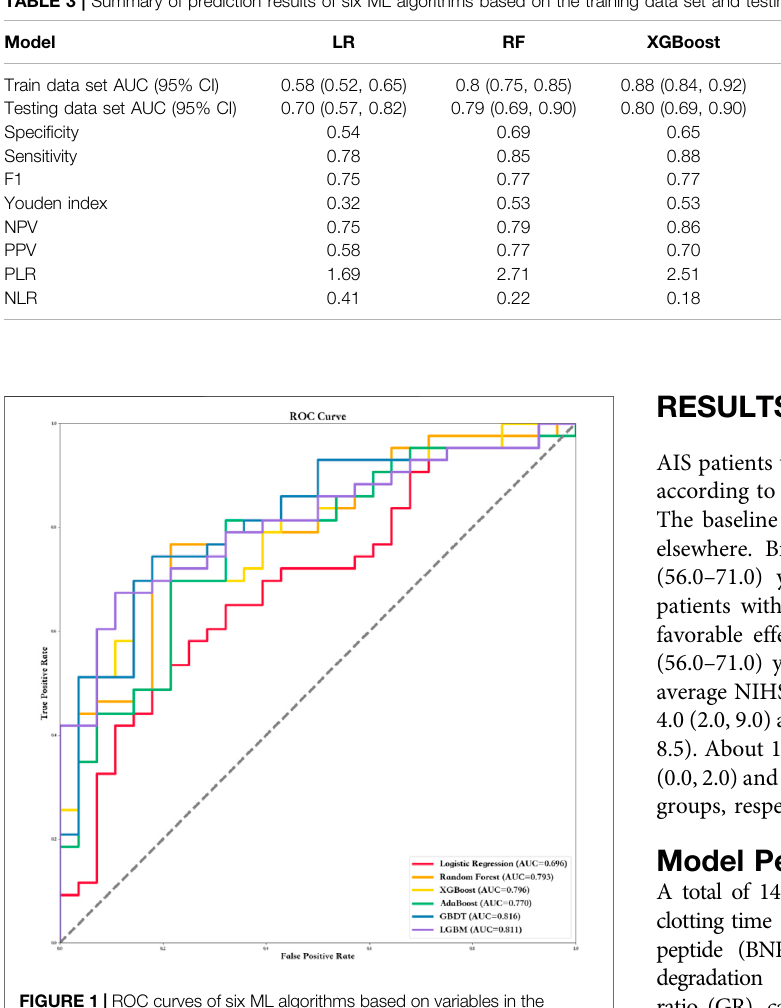
FIGURE 1 | ROC curves of six ML algorithms based on variables in the testing data set.